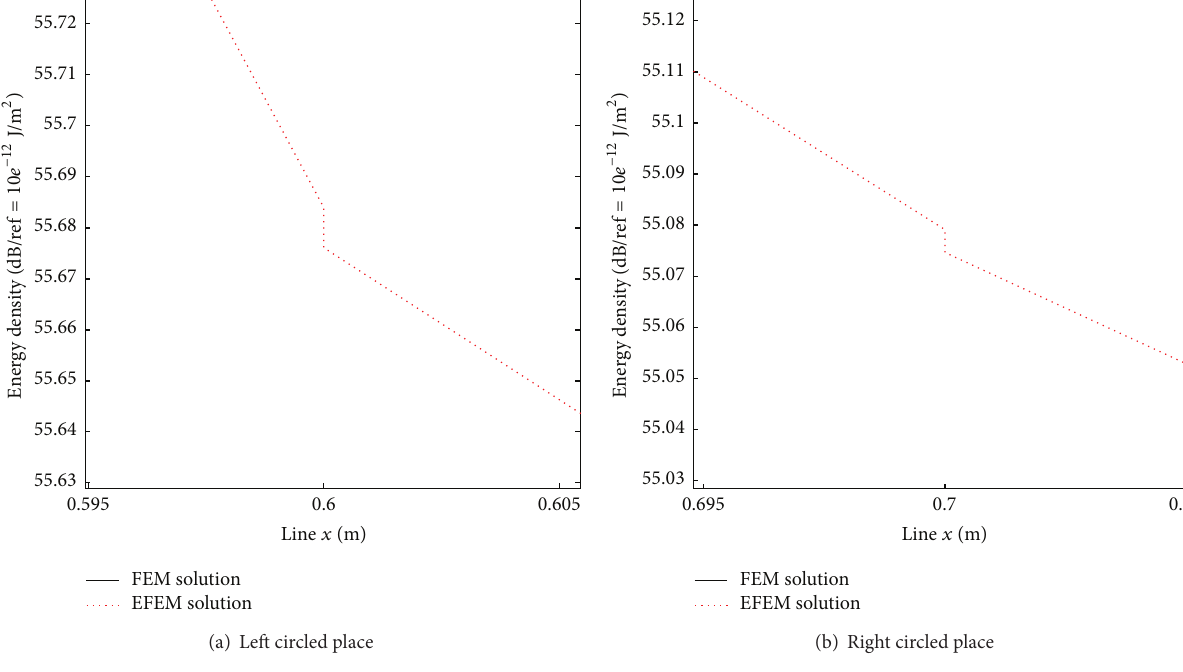
Figure 13: Detail view of circled places in Figure